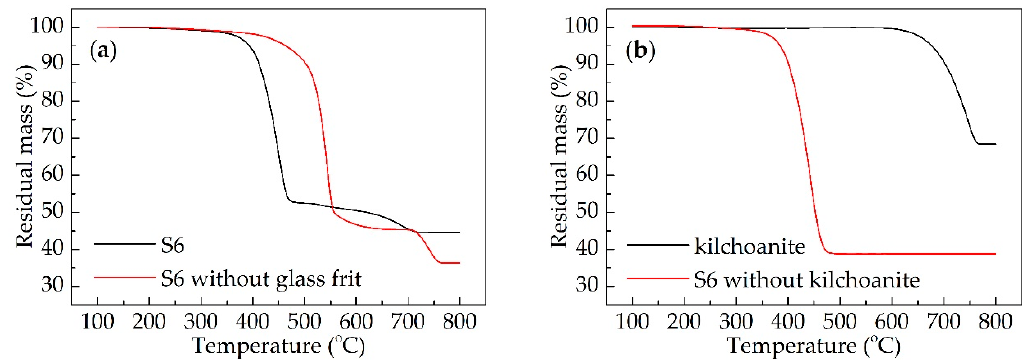
Figure 2. Thermogravimetric curves of different composites samples: ( a ) S6 and S6 without glass frit; ( b ) kilchoanite powder and S6 without kilchoanite.